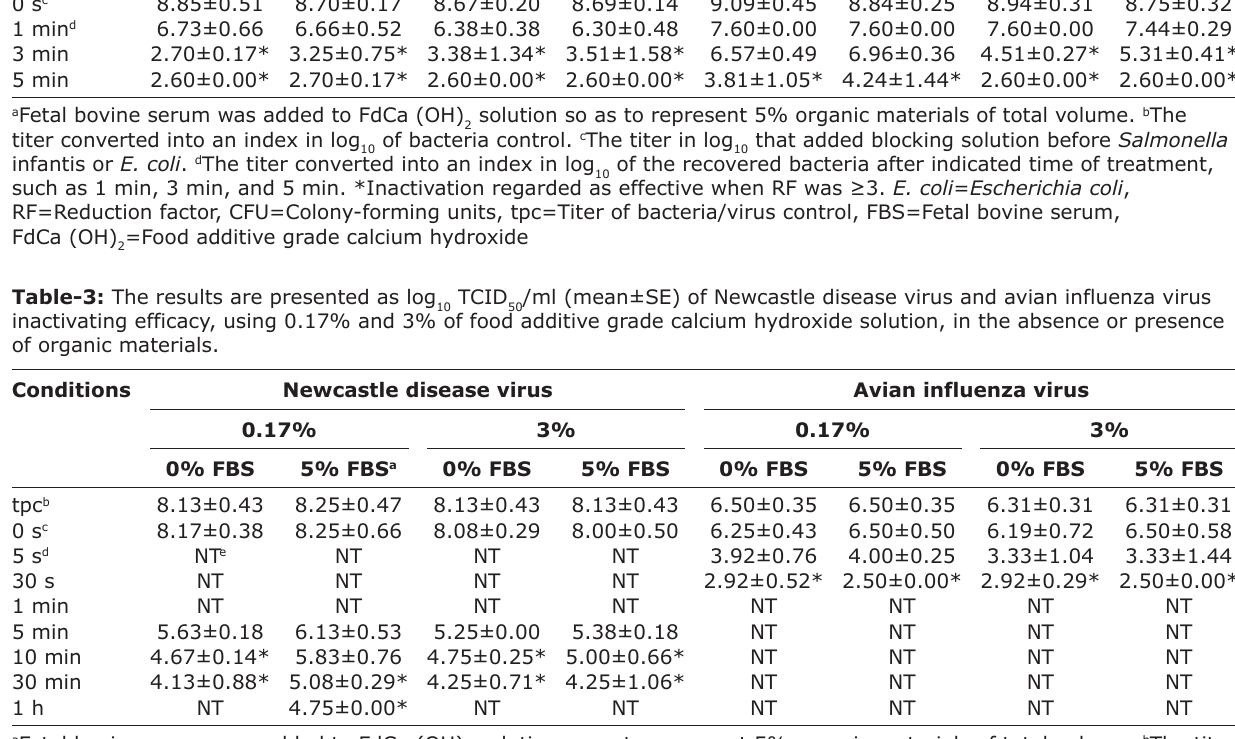
TCID /ml (mean±SE) of Newcastle disease virus and avian influenza virus 10 50